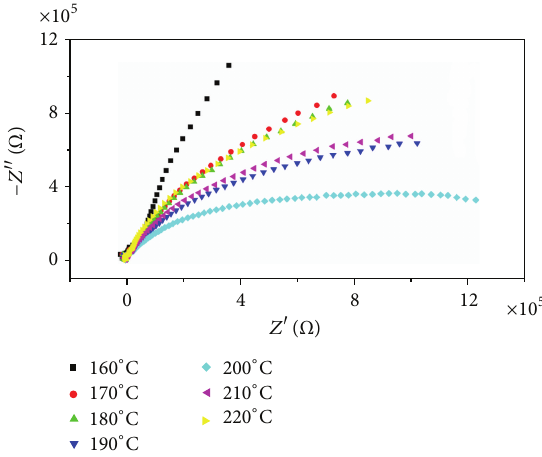
Figure 5: Complex plane impedance plots of polymer (P 2 ) at different